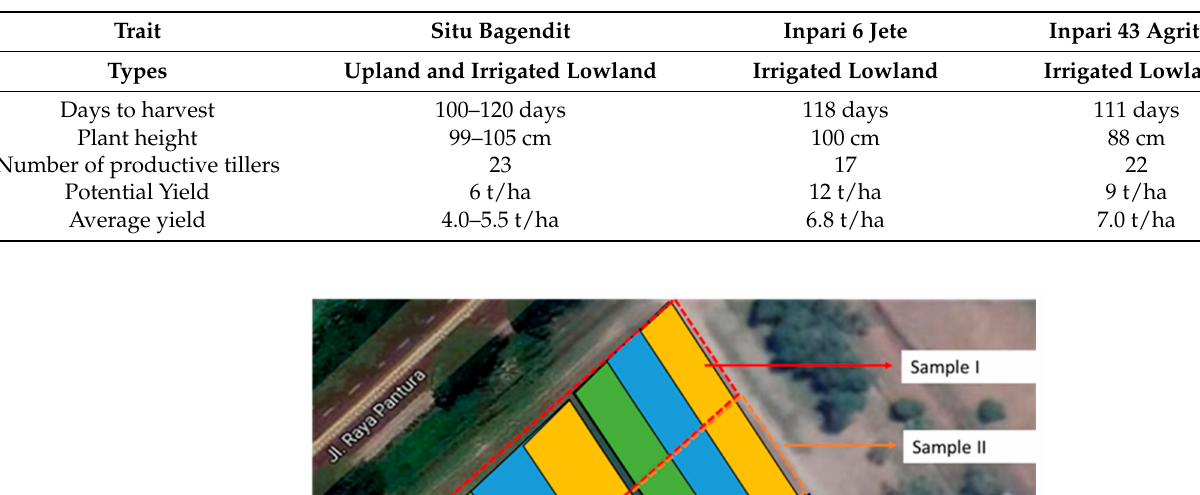
Table 1. Agronomic traits of the three varieties planted in the sheet-pipe (SP) and non-sheet-piped (NSP) fields.